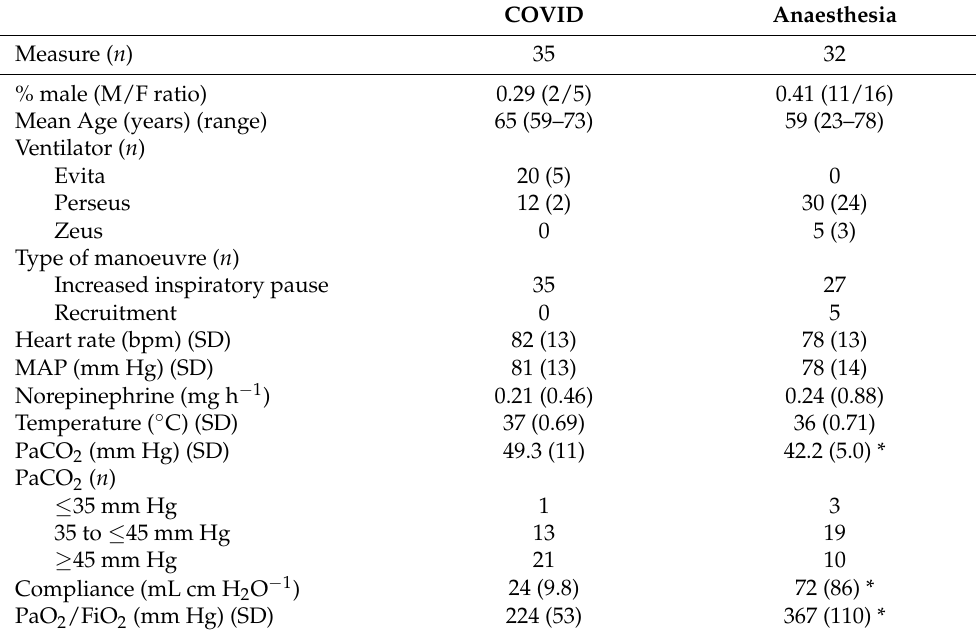
Table 1. Patient